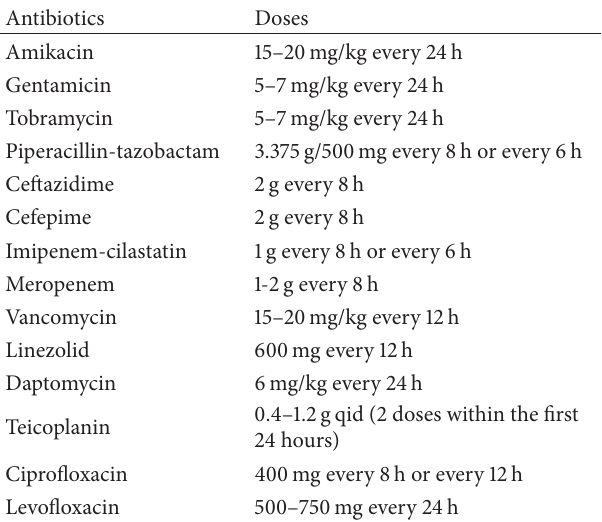
Table 4: Dosages of administrations of intravenous antibiotics for empirical treatment of febrile